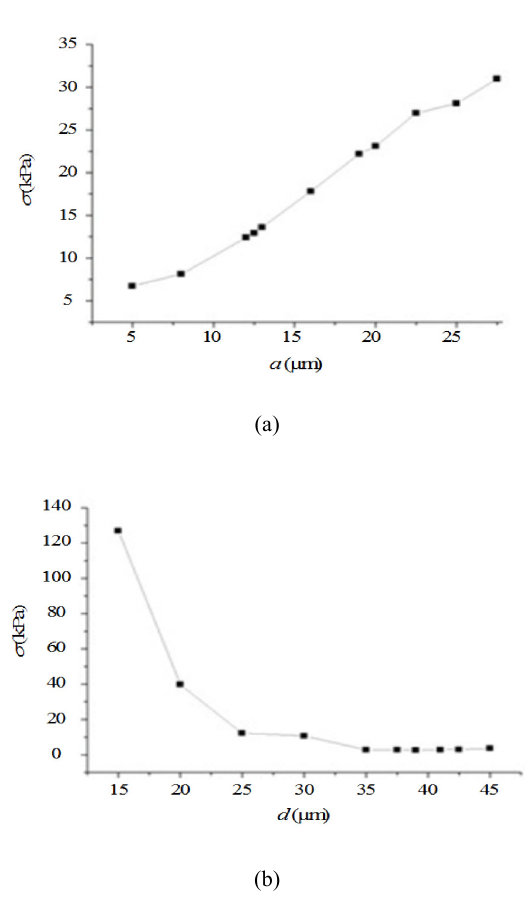
Fig. 10 Strain difference changes with (a) length a and (b) distance d at the temperature of 80 ℃ .